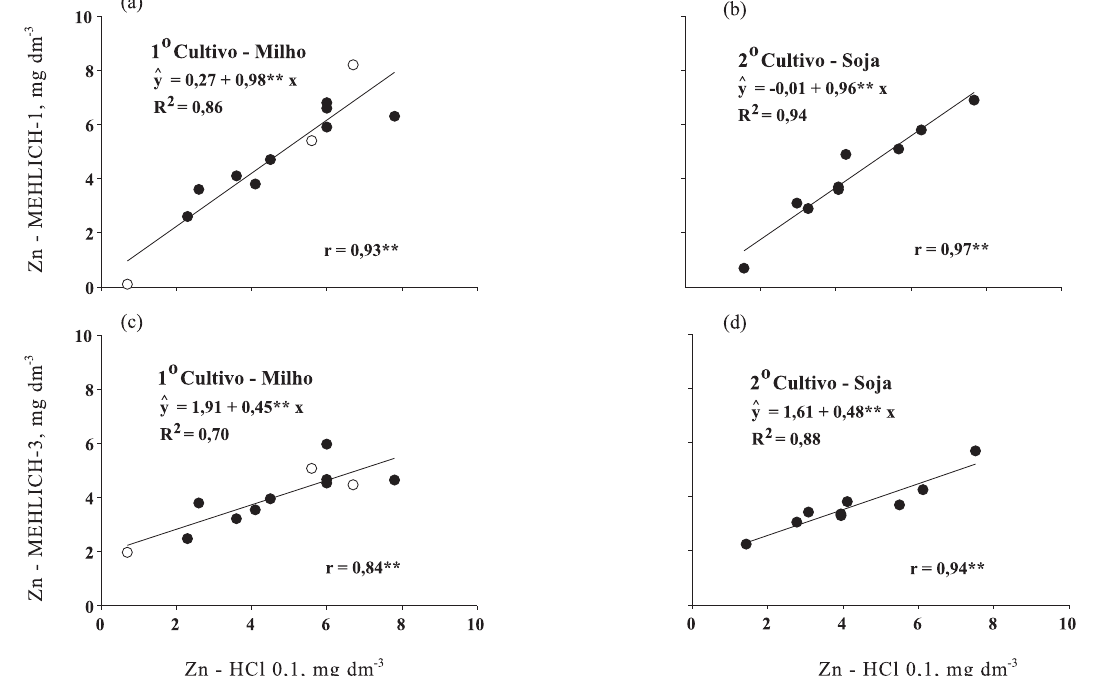
Figura 3. Relação entre os teores de zinco extraídos pelas soluções de HCl, Mehlich-1 e Mehlich-3, respectivamente, em amostras de solos coletadas antes do primeiro [(a) e (c)], com milho, e segundo cultivos [(b) e (d)], com